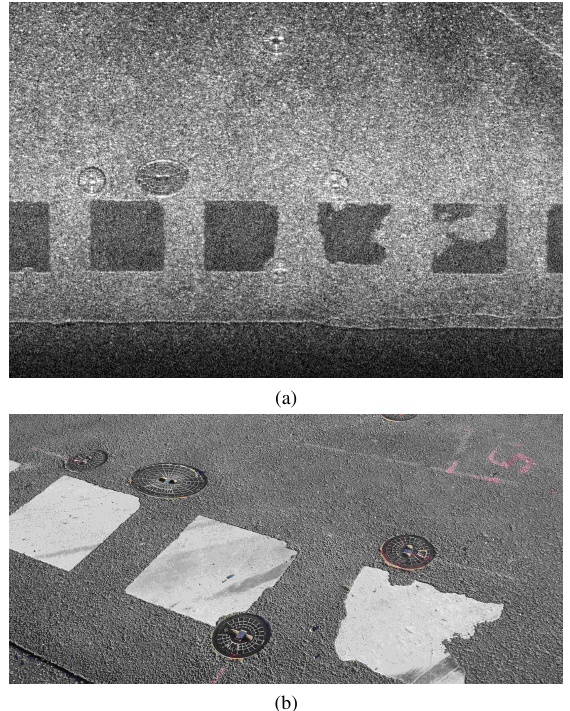
Figure 5: Zoom ( 4 m x 4 m) of gully covers and street intersec- tion: (a) SAR image zoom of the center of Fig. 4a. Orientation and texture of the gully covers is clearly observable in the zoom. Also fraying or missing elements of the white road markings and cracks in the asphalt are detectable. (b) Photograph of the scene.